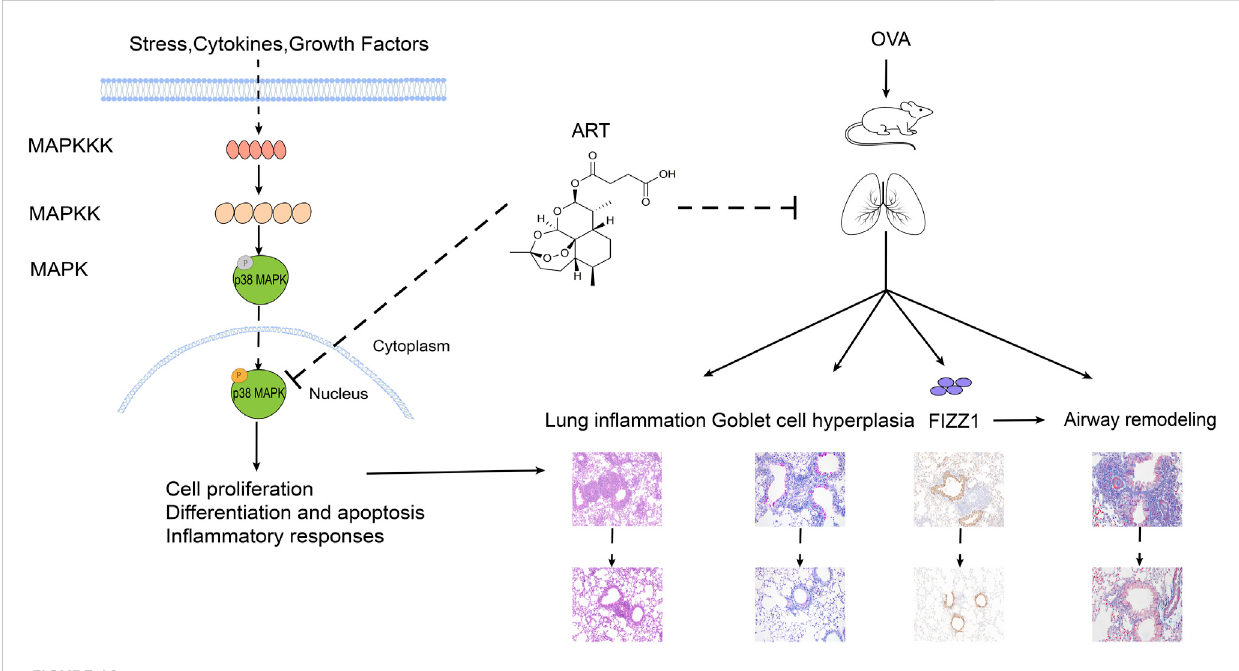
FIGURE 10 Potential mechanism of ART alleviating OVA-induced asthma by inhibiting p38 MAPK signaling